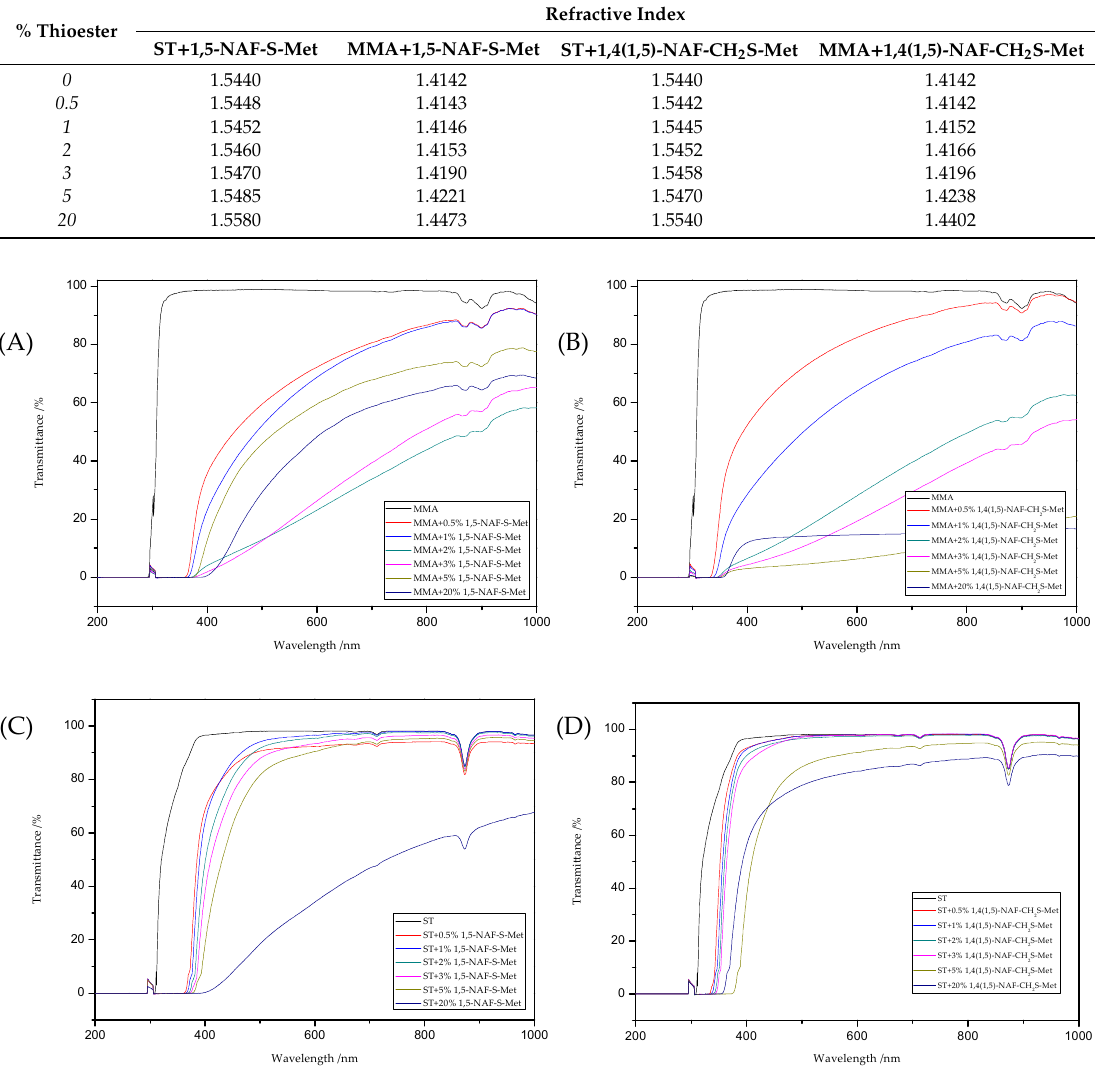
Figure 11. TheUV / vistransmittancespectraofthepreparedliquidcompositionswiththedifferentaddition Figure 11. The UV/vis transmittance spectra of the prepared liquid compositions with the different of dithioesters: MMA + 1,5-NAF-S-Met ( A ), MMA + 1,4(1,5)-NAF-CH 2 S-Met ( B ), ST + 1,5-NAF-S-Met ( C ), addition of dithioesters: MMA+1,5-NAF-S-Met ( A ), MMA+1,4(1,5)-NAF-CH 2 S-Met ( B ), and ST + 1,4(1,5)-NAF-CH 2 S-Met ( D ST+1,5-NAF-S-Met ( C ), and ST+1,4(1,5)-NAF-CH 2 S-Met ( D ).